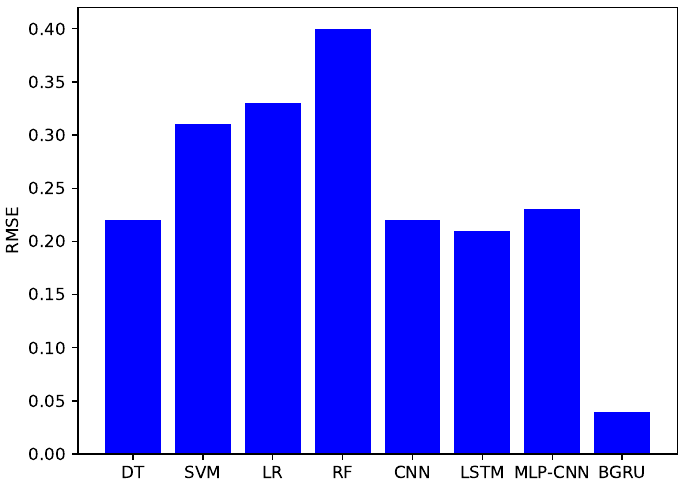
Figure 14. Comparison of BGRU with other techniques in term of Root Mean Square Error (RMSE). The existing techniques have low ROC curve as compared to the proposed model. ROC curve of CNN is 0.65, LR is 0.73, SVM is 0.57, LSTM is 0.82, MLP-CNN is 0.81, and RF is 0.70, respectively. Figures 15–22 show the experimental results of comparative techniques in terms of ROC. Among